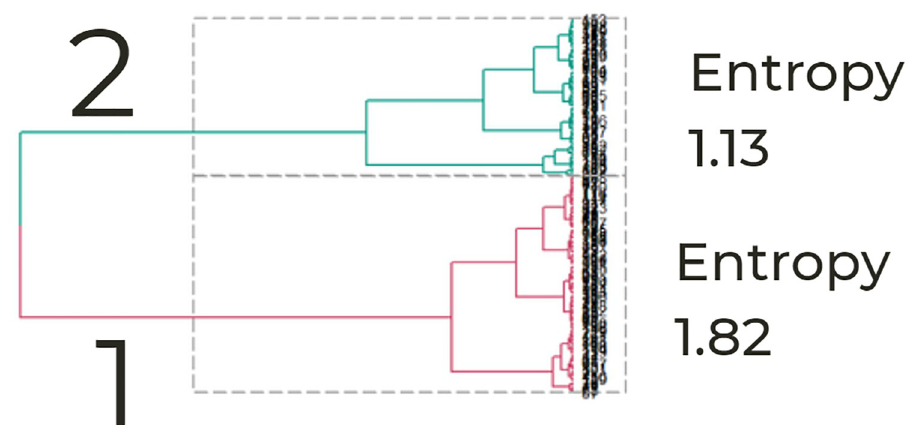
Fig 6. Phenotypes: Two clusters. Hierarchical Ward’s clustering and identified two phenotypes based on the first split. Phenotype one was the “high” entropy cluster. Admissions in phenotype 1 had a higher mean illness score and a higher composite score representing higher illness severity.